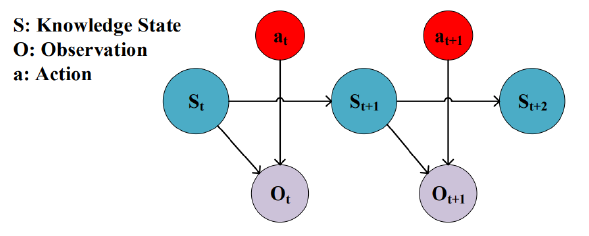
Figure 1. Partially observable Markov decision process